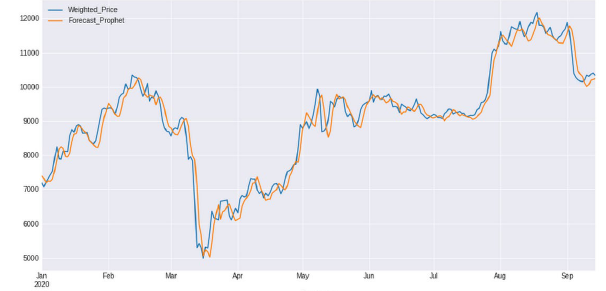
Figure 8. FBProp Performance